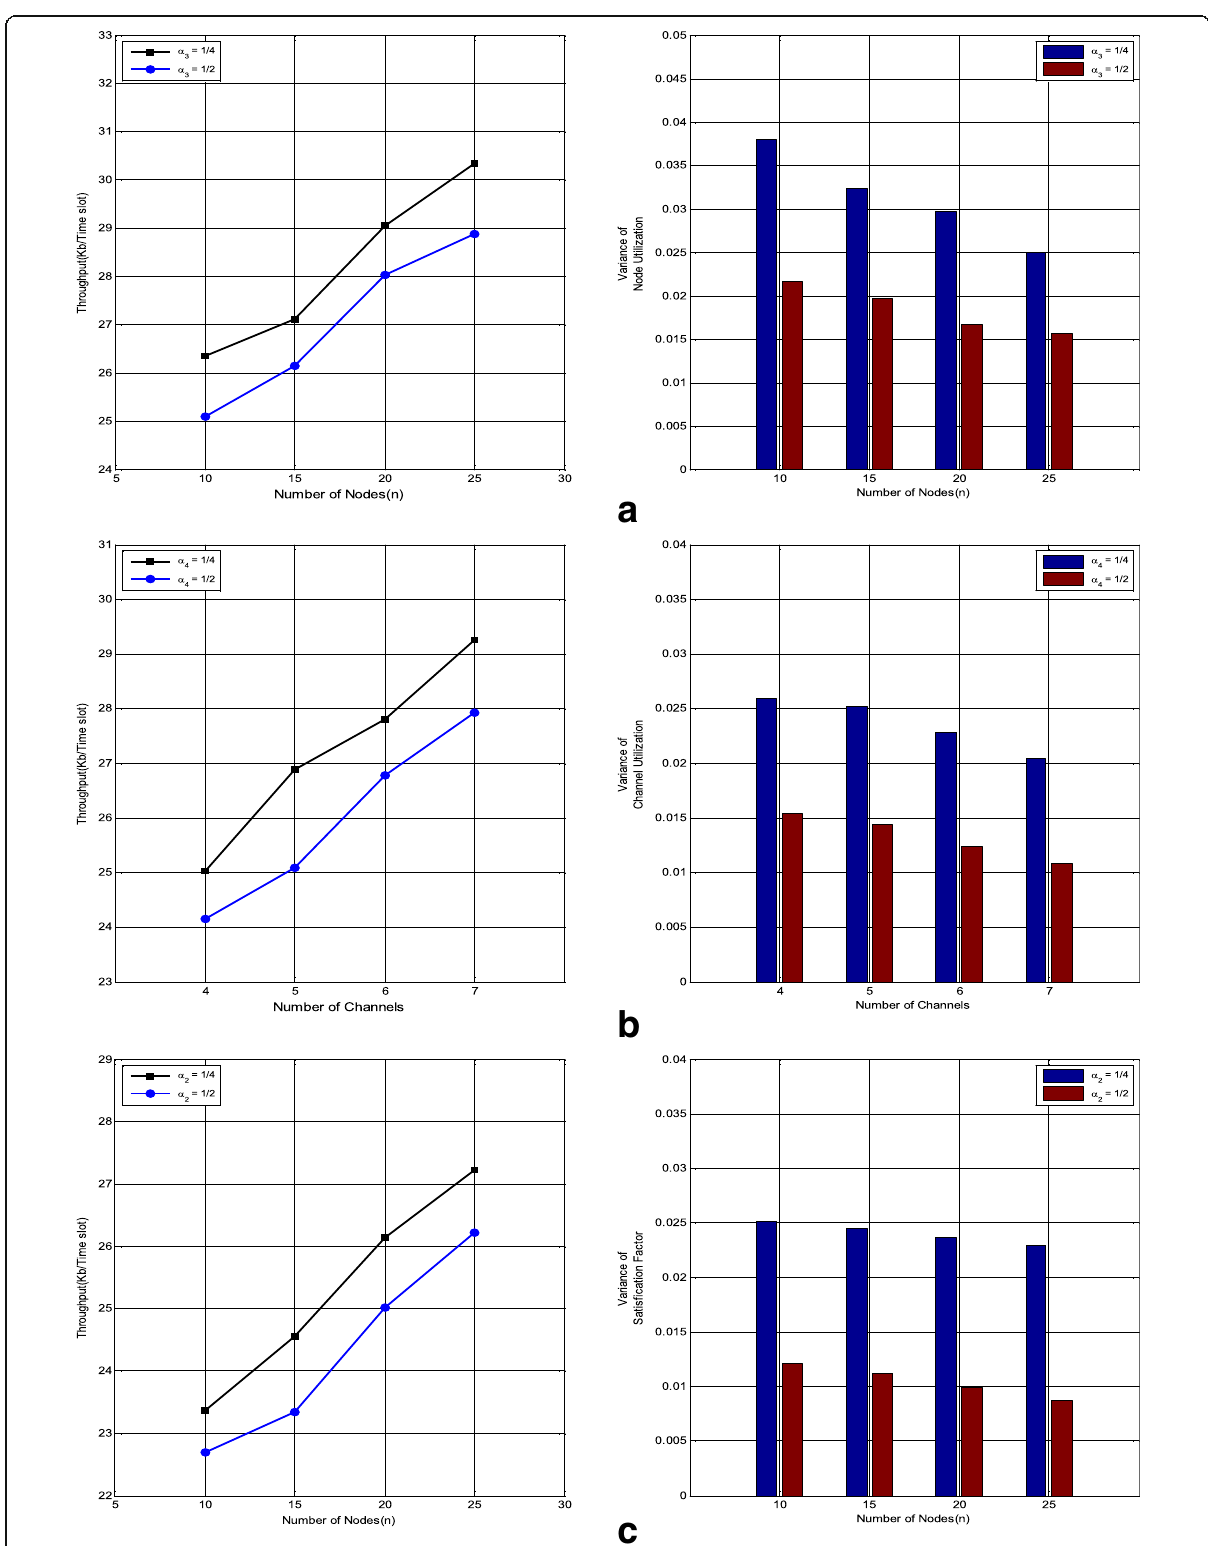
Fig. 5 Analysis of the impact of the fairness and balancing factors on the throughput in FTTC-TMBF ( a ) impact of the node utilization balancing factor ( b ) impact of the channel utilization balancing factor ( c ) impact of the fairness